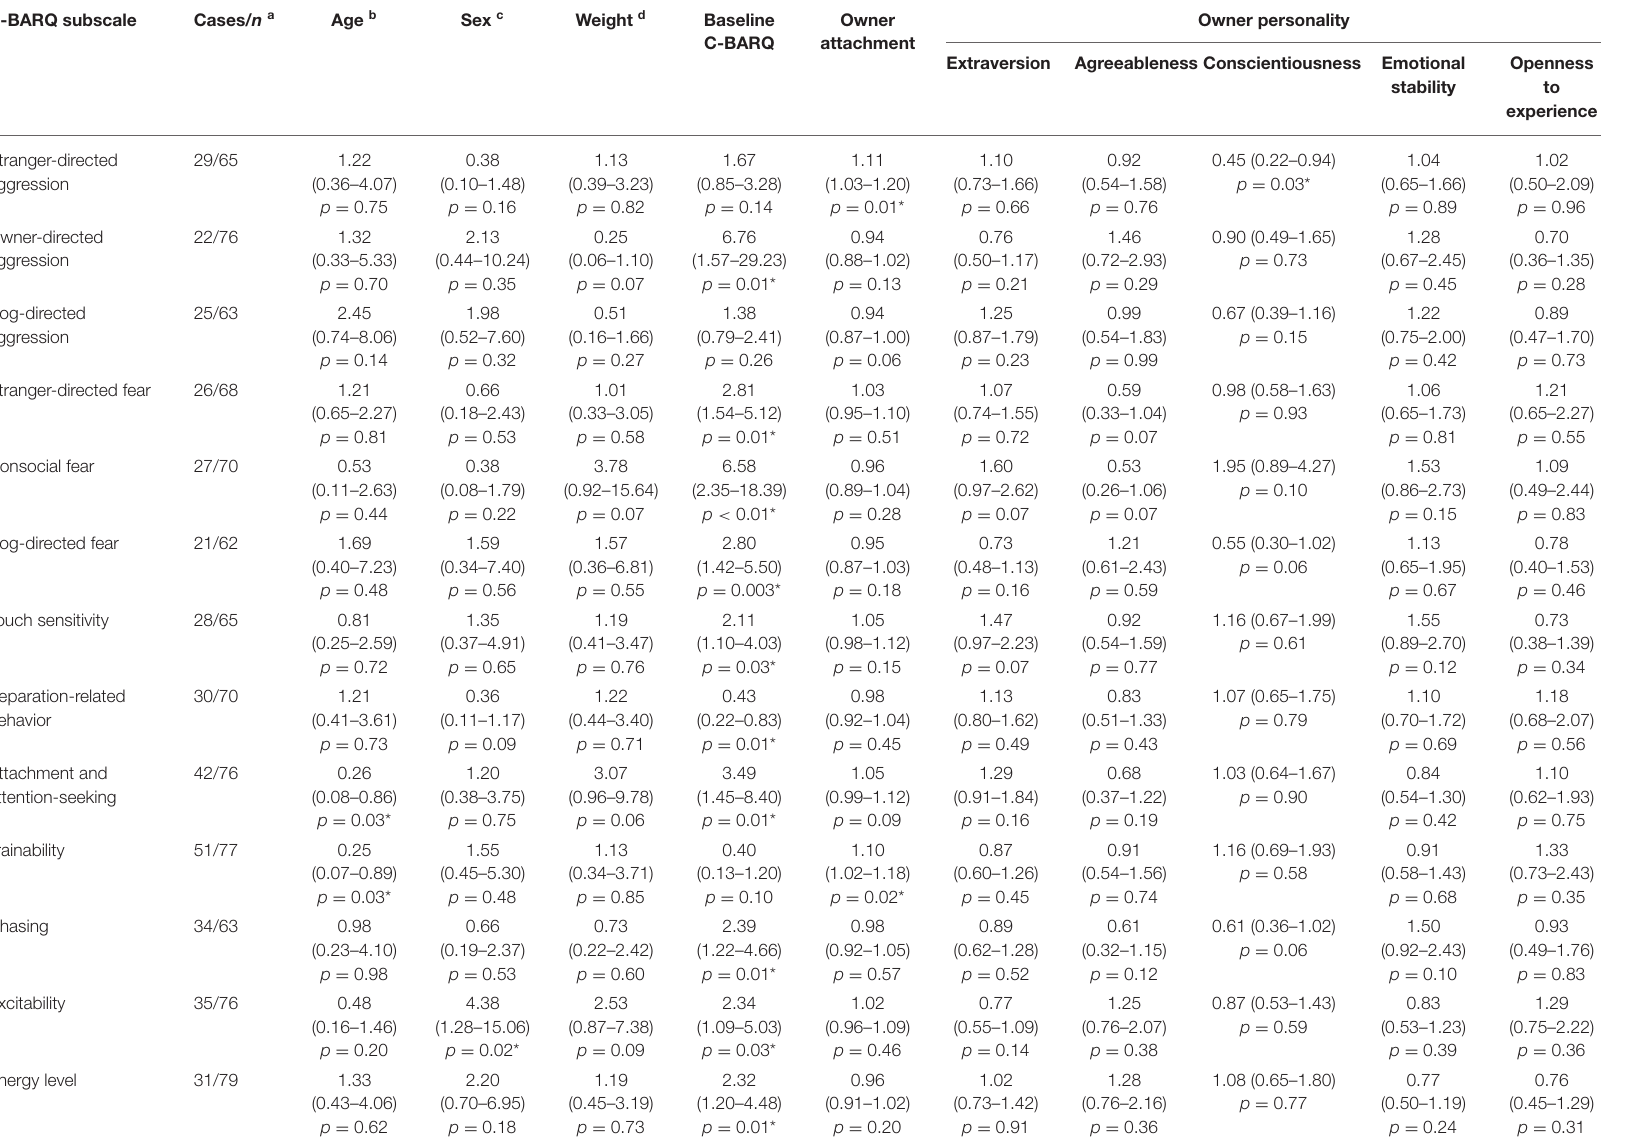
TABLE 5 | Logistic regression describing the associations between positive treatment outcomes at 6-months and owner and canine